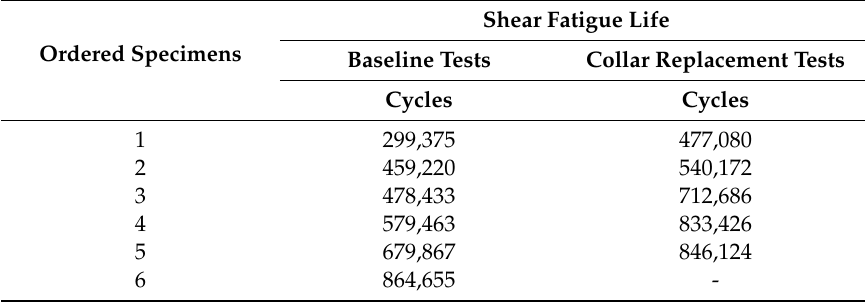
Table A3. Experimental data for shear fatigue life—Figure 7.